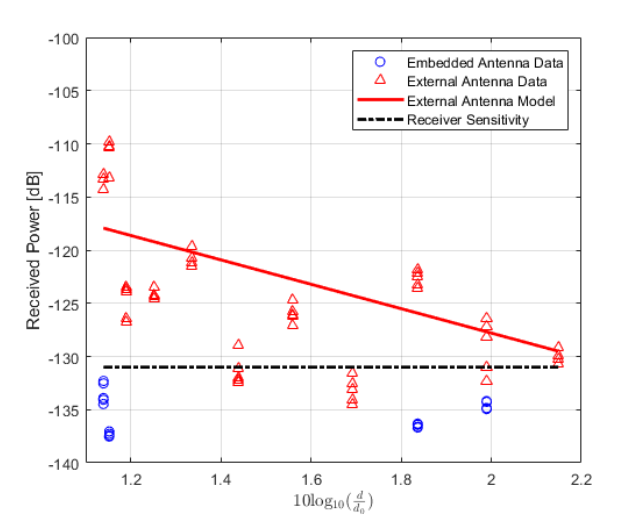
Figure 7. IQRF received power model for Non-Line-of-Sight scenario (two-turns).